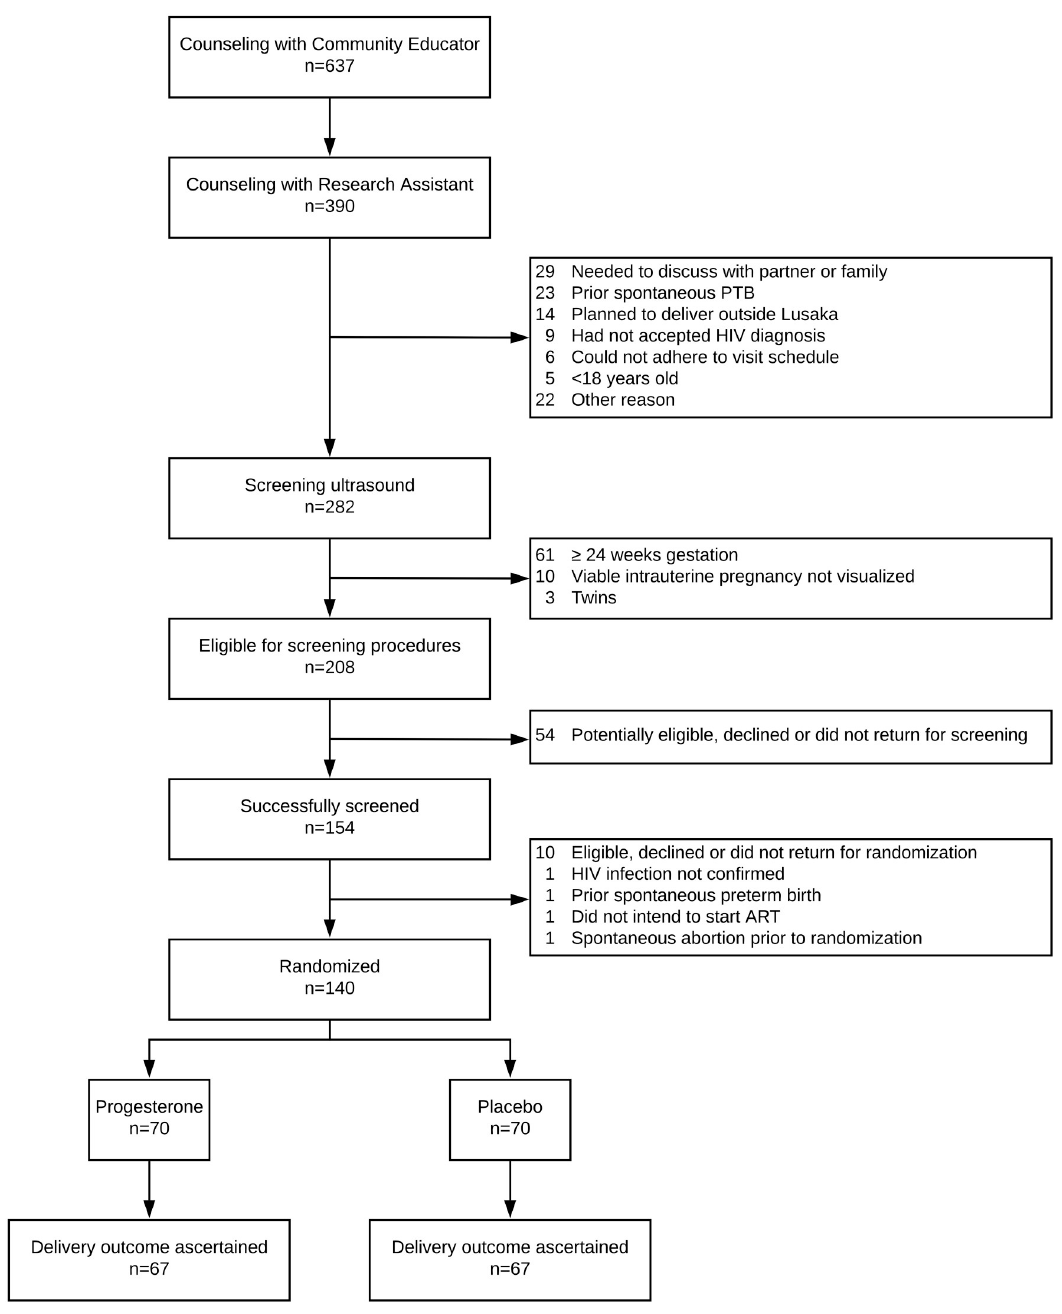
Fig 1. Participant